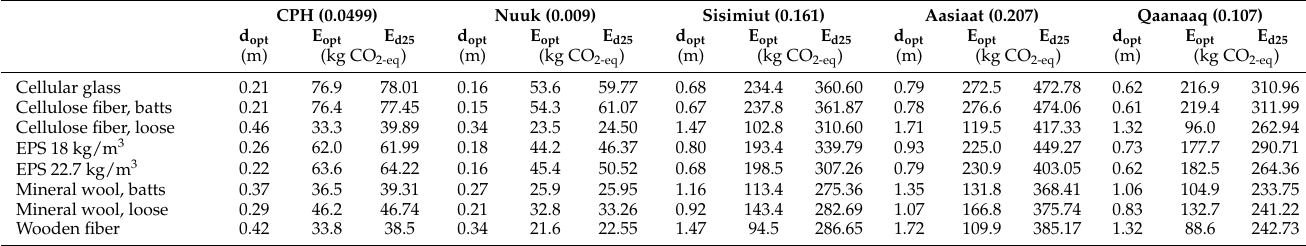
Table 5. Scen ins results produced by ITO for chosen locations with constant climate. The secondary pre-sets are production and heat waste of 5%, ESL of 60 years, and incineration as waste handling. CPH (0.0499) Nuuk